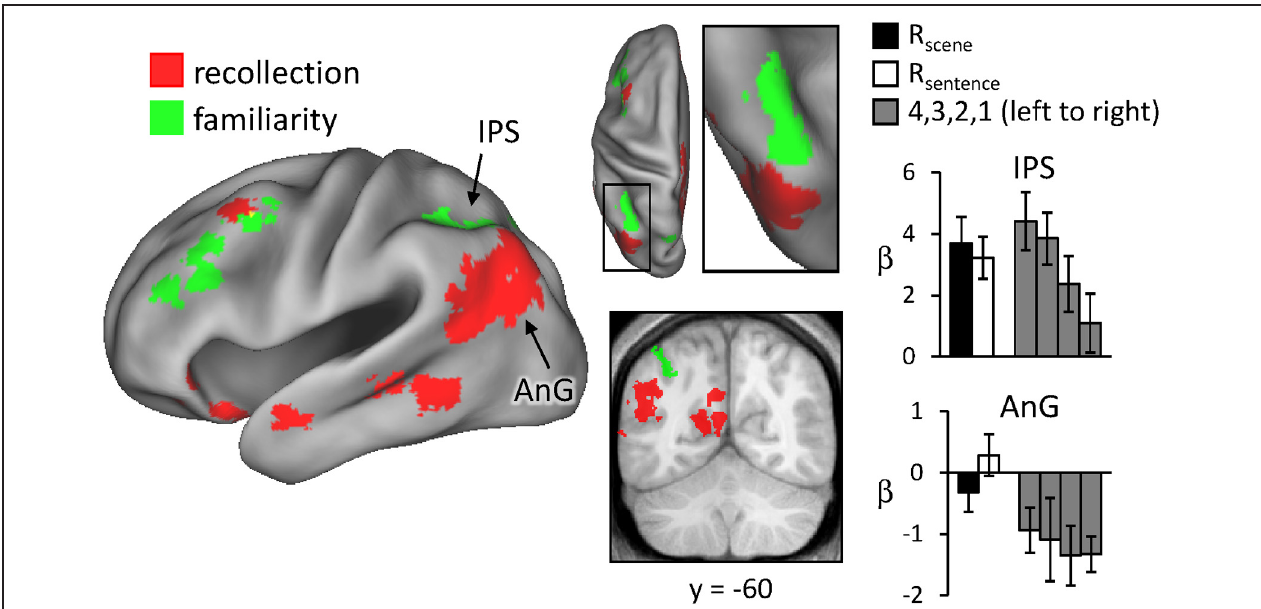
Effects here and in subsequent figures are projected onto a standardized PALS-B12 surface (see Materials and Methods) and overlaid on the across-subjects mean normalized T1-weighted image. Histograms indicate mean parameter estimates ( β ) from the peak voxel of each effect in angular gyrus (AnG) and intraparietal sulcus (IPS). R (remember); 4, 3, 2, 1 (confidence